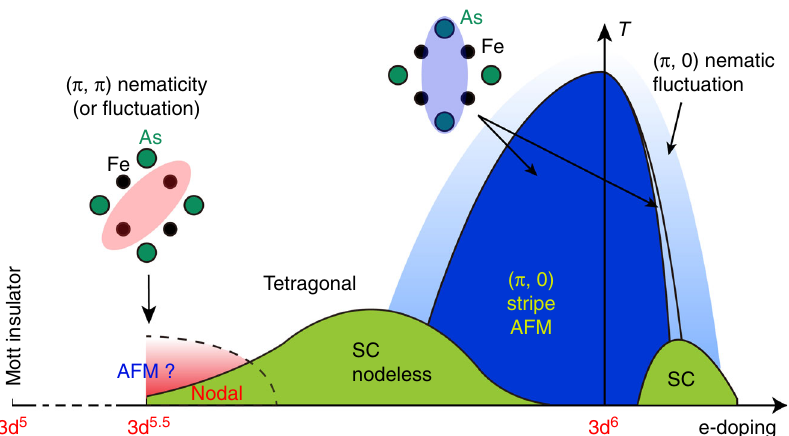
Fig. 7 Schematic phase diagram of 122 type iron pnictides (based on refs. 1 – 3,15 and the data of this work). The blue area denotes ( π , 0) stripe AFM which coexists with the ( π , 0) nematicity, and the light blue area denotes ( π , 0) nematic fl uctuation. The two green areas are superconducting dome. The red area denotes ( π , π ) nematicity at the 3d 5.5 con fi guration (which may become ( π , π ) nematic fl uctuation at increased temperature). For the hole-doping superconducting dome, electron pairing is nodeless ( s ± ) in the middle of the dome, but became nodal ( d x 2 (cid:1) y 2 like) as approaching 3d 5.5 . A Mott insulator phase is theoretically expected at the 3d 5 con fi guration. The upper insets demonstrate the symmetry breaking in ( π , 0) and ( π , π ) nematic